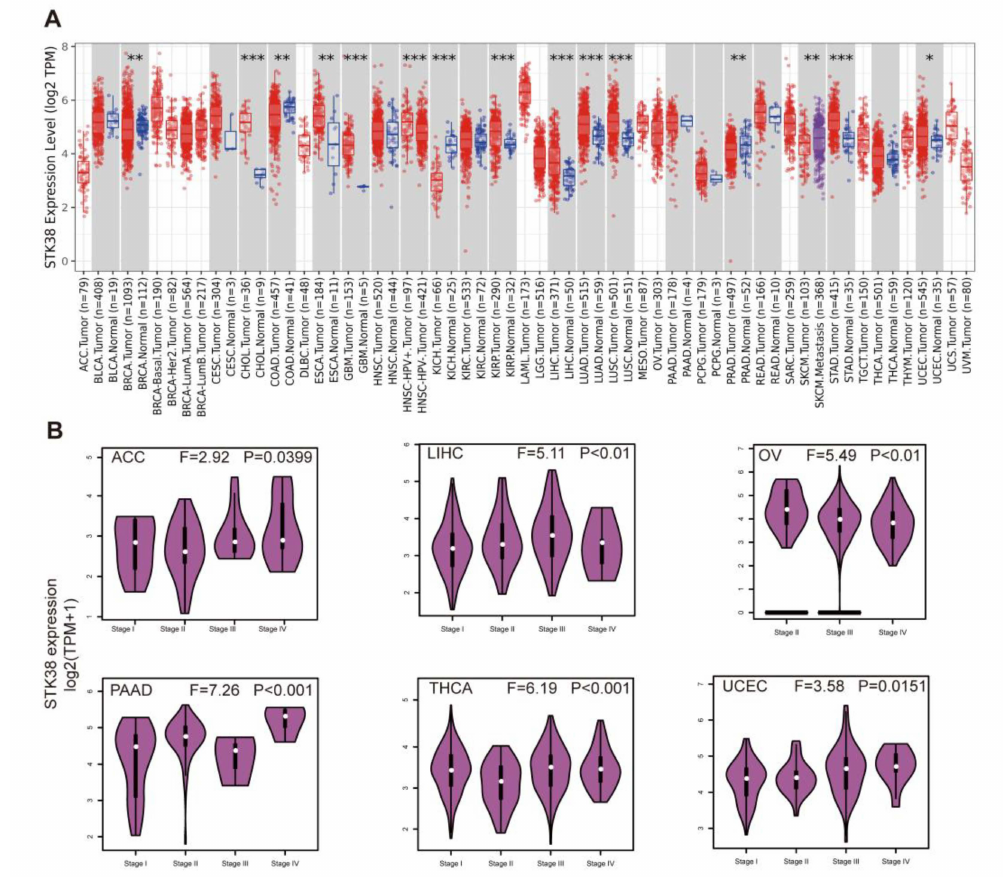
Figure 1. STK38 expression profiles in normal tissues and cancers. ( A ) STK38 expression level in TCGA tumors were analyzed using TIMER2.0 database (* p < 0.05; ** p < 0.01; *** p < 0.001). The red color represents tumor tissue samples, and the blue color represents normal